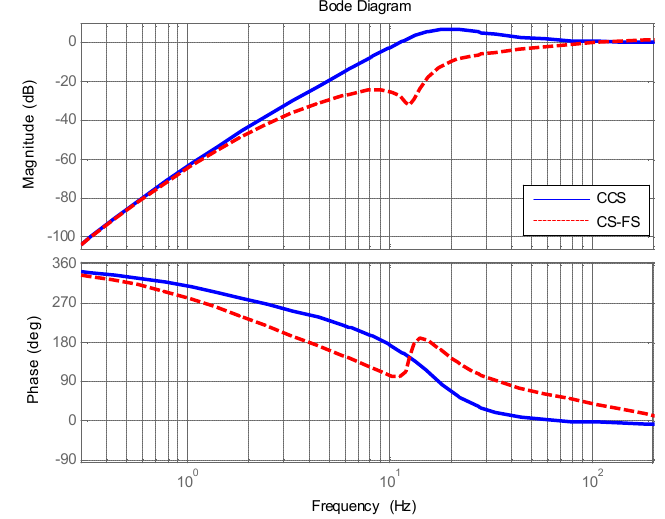
Figure 5. Disturbance rejection performance of classic control structure (CCS) and CS-FC.